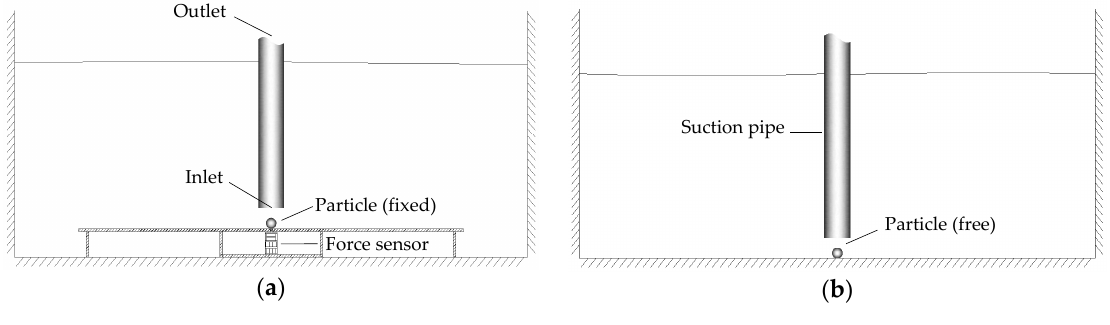
Figure 5. ( a ) Sketch of vertical force tests and ( b ) vertical incipient motion tests.